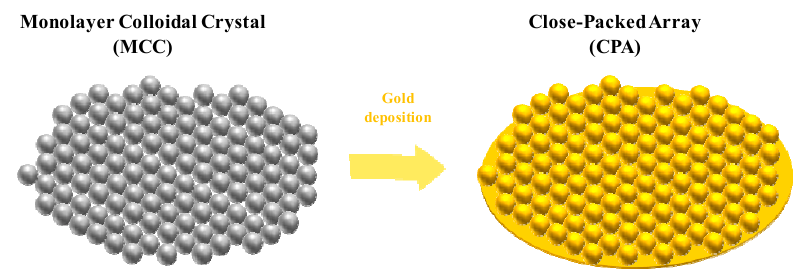
Figure 1. Schematic of the nanospheres substrate in close-packed array configuration.